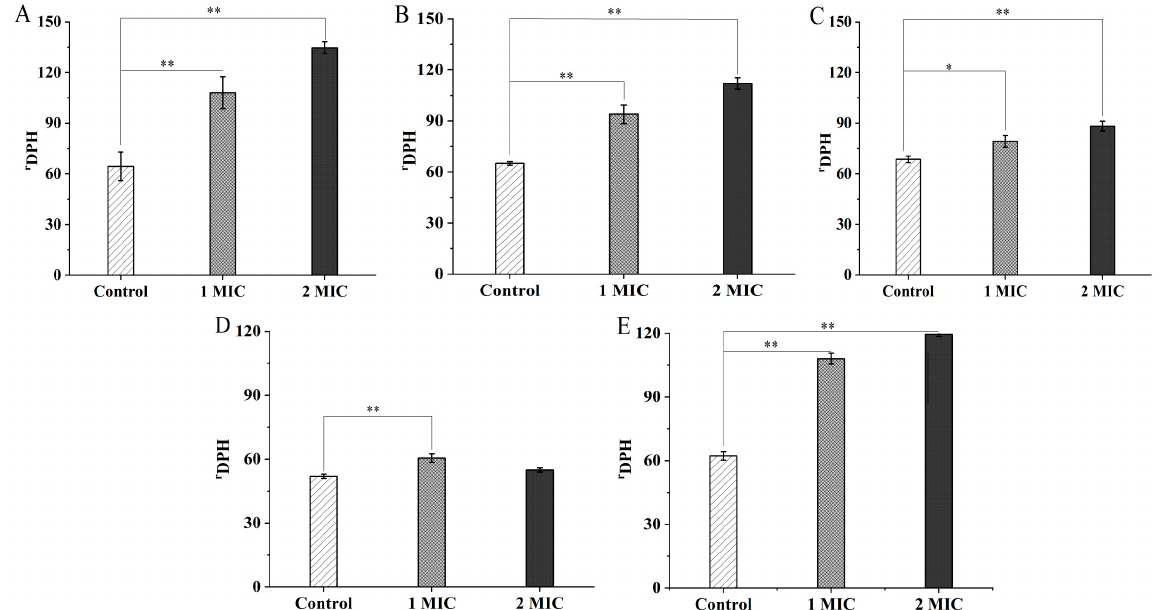
Figure 2. The effects of the GMPE on bacterial cell membrane fluidity. ( A – E ) S. aureus ATCC8095, A. hydrophila, E. sakazakii CMCC45401, V. metschnikovii ATCC700040, and V. parahaemolyticus ATCC17802, respectively. *: p < 0.05, and **: p <